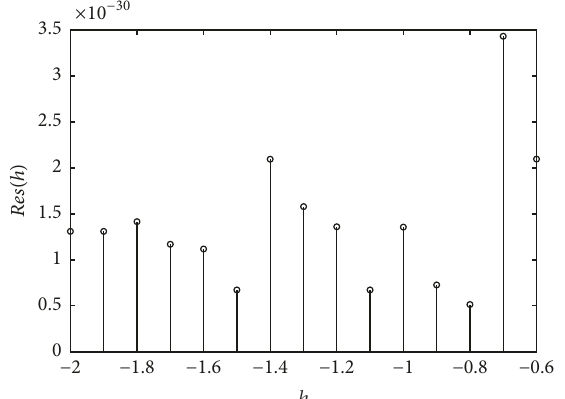
Figure 8: The approximate optimal ℎ ( ℎ = −0.8 ) for 𝑁 = 10 for Example 3.